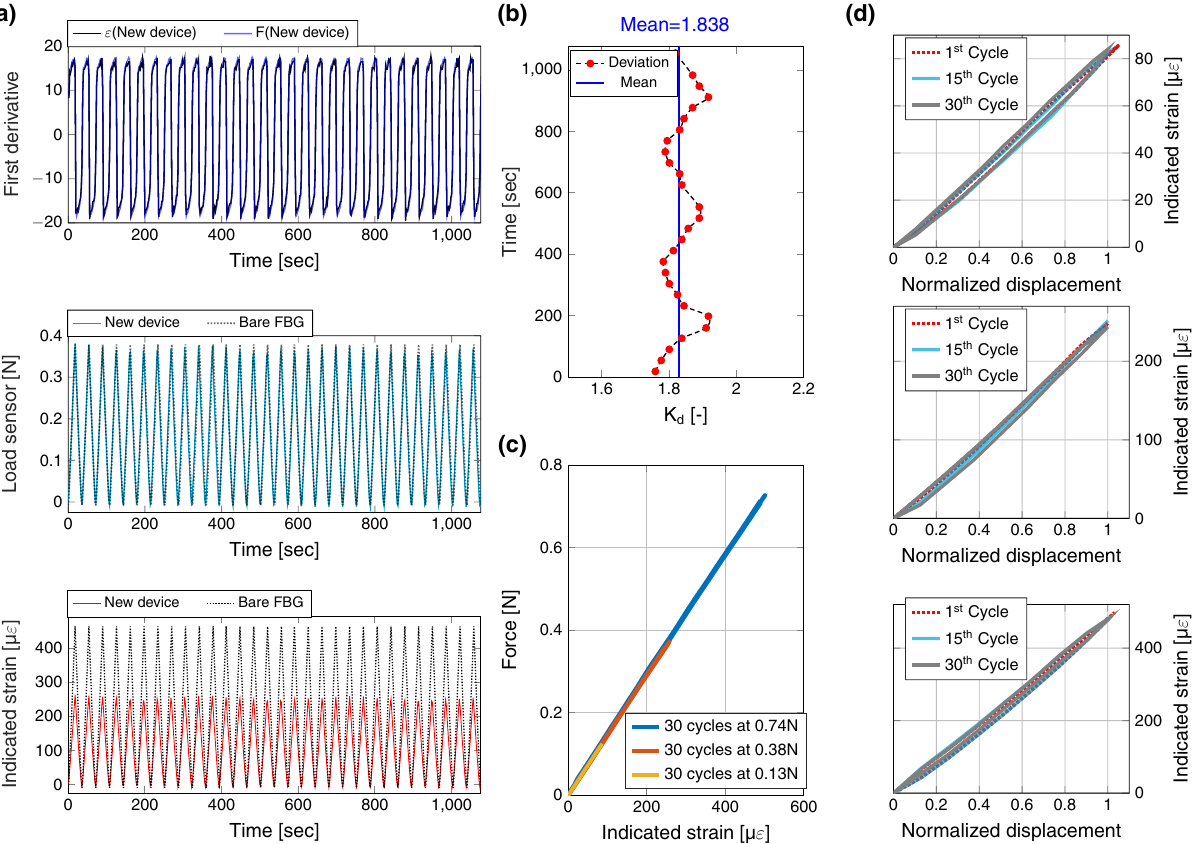
Figure 4. ( a ) The measured strain for 30 cycles for the load level of 0.38 N; ( b ) the measured force for the new CBPM-FBG holder and bare FBG; ( c ) the first derivative of the measured force and strain; ( d ) the standard deviation of derived K d (based on input and FBG strain) during three typical cycles. [The graphs are generated using latex-pgf plot